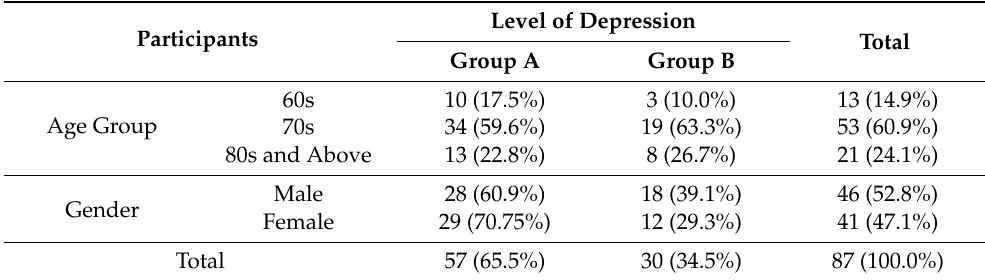
Table 1. Classification of investigation